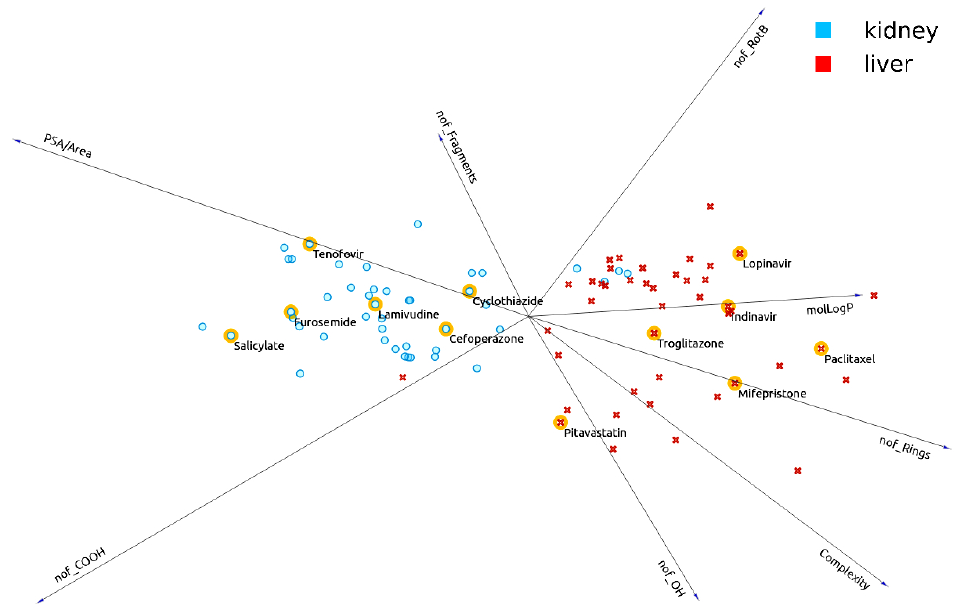
Figure 3. 12 drugs with a propensity for interaction with either kidney OATs or liver OATPs high- lighted in FreeViz diagram. Quantitative information for the eight molecular properties pertaining to each drug are shown in Table